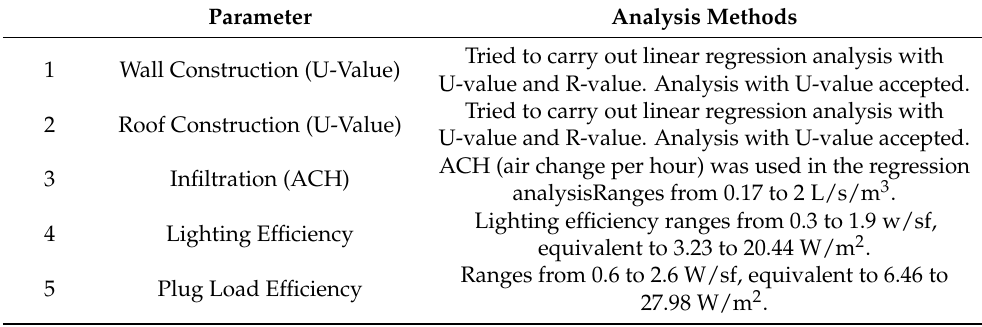
Table 6. Summary of Design